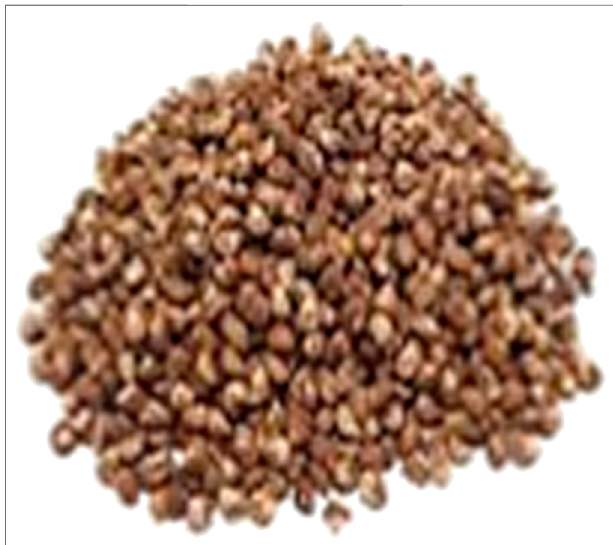
FIGURE 2 | Tobacco